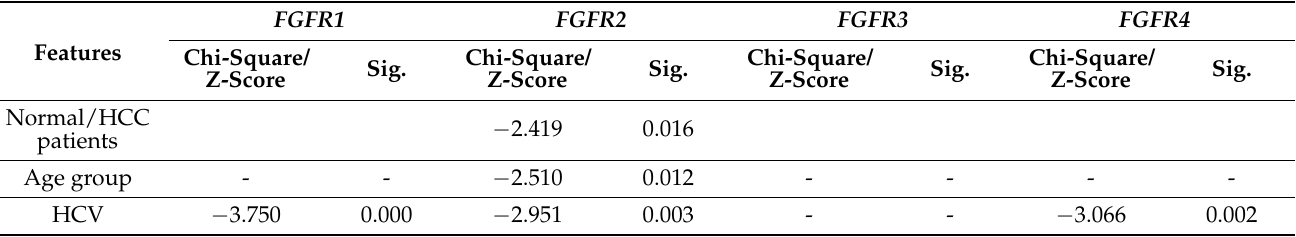
Table 2. Association of FGFRs’ expression with clinical